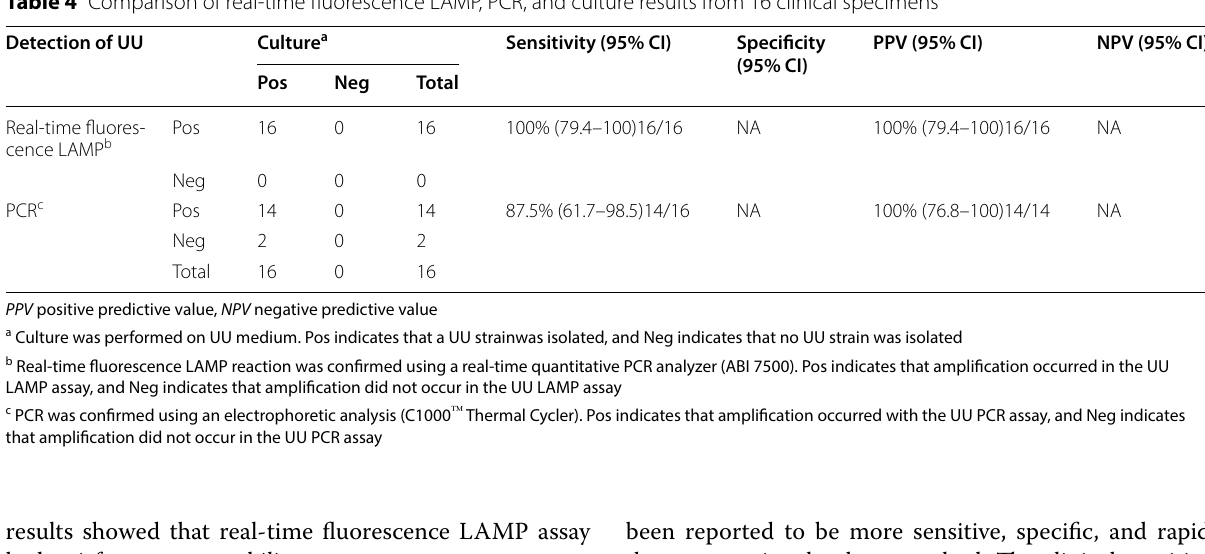
Table 4 Comparison of real‑time fluorescence LAMP, PCR, and culture results from 16 clinical specimens